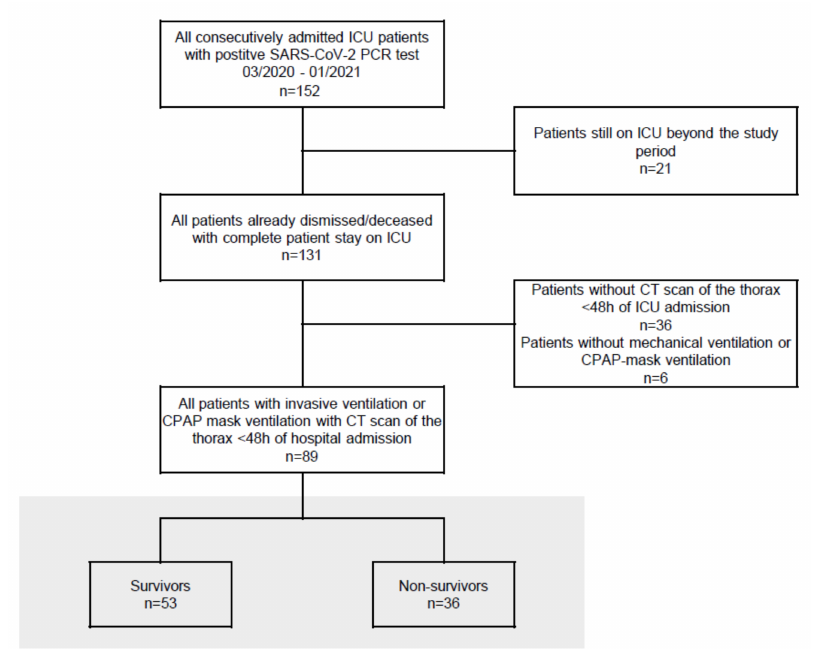
Figure 1. Study flow chart. All patients from the participating ICUs with positive SARS-CoV PCR